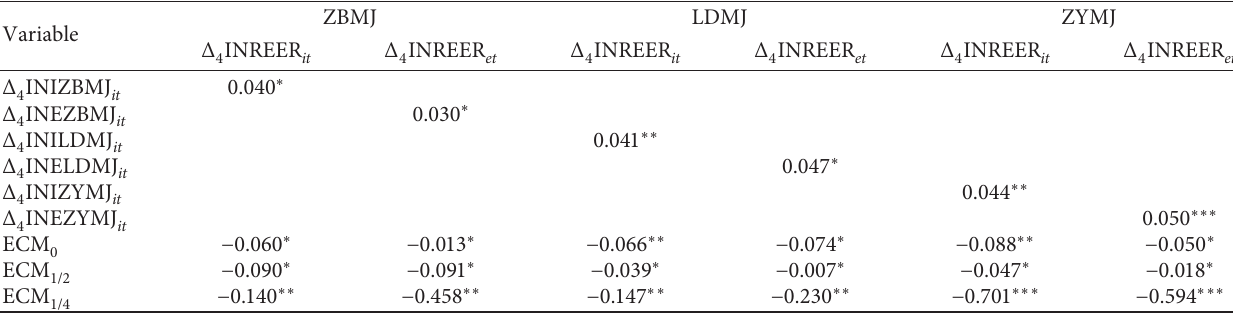
Table 5: Seasonal error correction